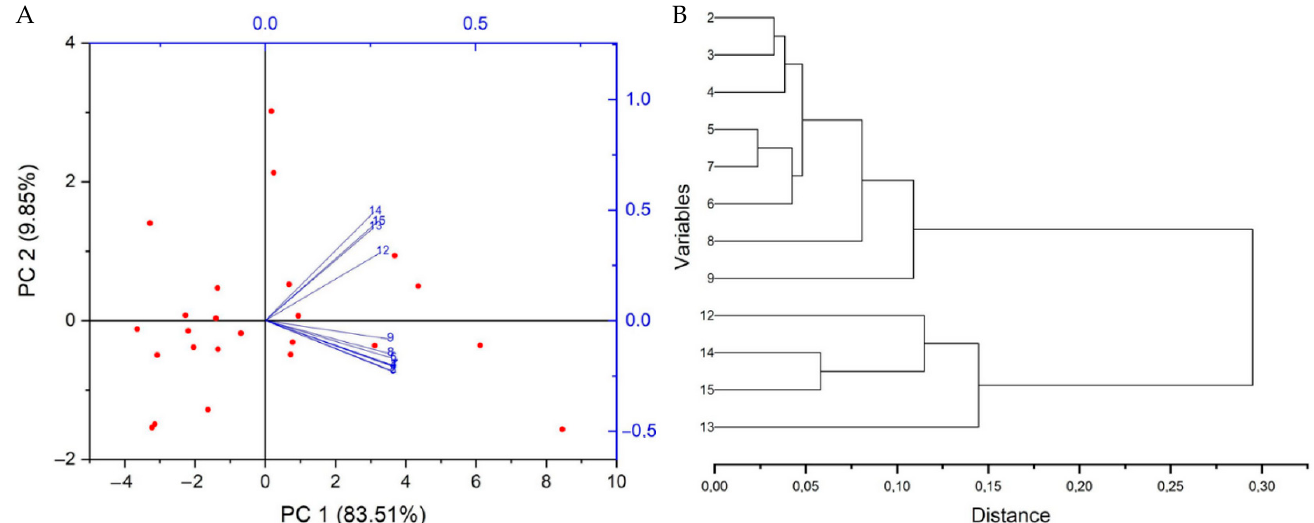
Figure 8. Statistical analyses for total phosphorus (TP): PCA ( A ) and HCA ( B ; this research).